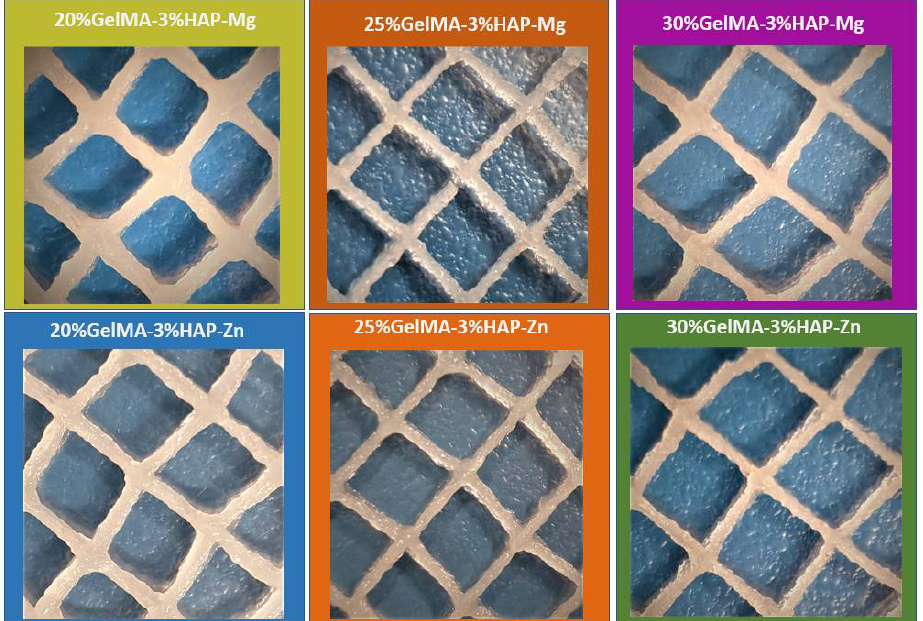
Figure 9. 3D printed hydrogel scaffolds: 20%GelMA-3%HAP-Mg, 25%GelMA-3%HAP-Mg, 35%GelMA-3%HAP-Mg, 20%GelMA-3%HAP-Zn, 25%GelMA-3%HAP-Zn, and 35%GelMA-3%HAP-Zn.